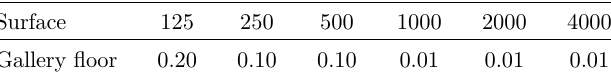
Table 3. Sound transmission coef fi cients by octave band center frequency (Hz) for speci fi ed surfaces in the